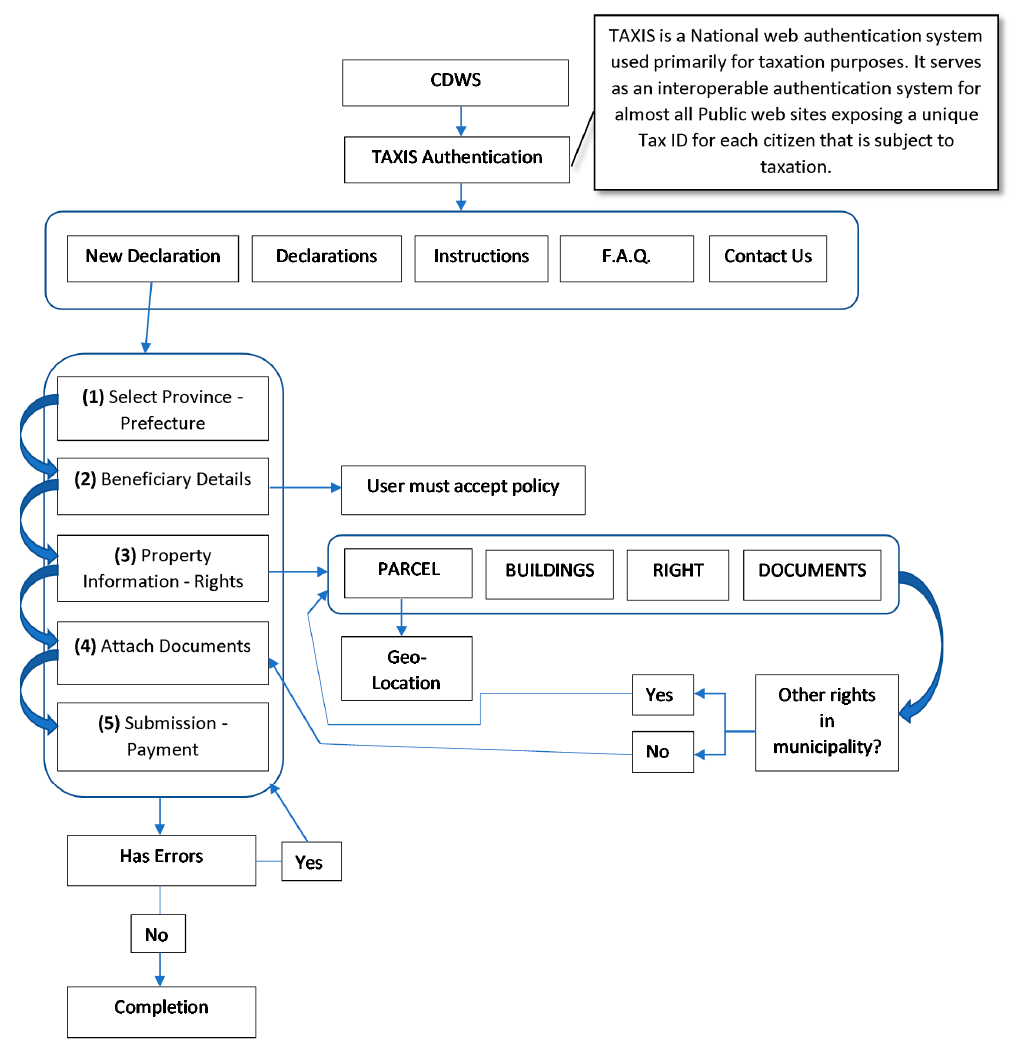
Figure 2. Web site’s flow diagram of the e-declaration process.